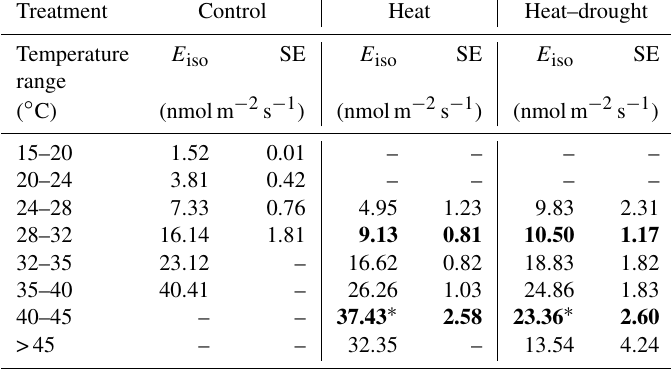
Table B1. Bin-averaged isoprene emissions ( E iso ) for different temperature classes including the corresponding standard errors (if n> 1). Significant differences in E iso between treatments and con- trol are given in bold ( p< 0 . 05 based on a t -test if the number of measurements exceeded three). Values denoted with ∗ indicate sig- nificant differences between the heat and heat–drought